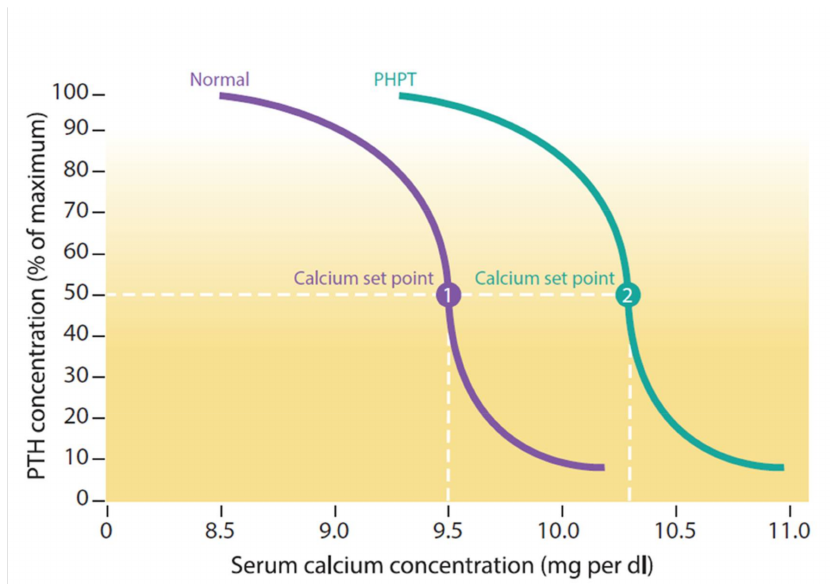
Figure 4. The purple line shows the normal relationship between calcium and parathyroid hormone concentrations and the green primary hyperparathyroidism (PHPT) curve is shifted to the right (higher levels of PTH at each calcium). The calcium set point (dotted line) corresponds to the concentration of calcium at which PTH secretion is at 50%. In primary hyperparathyroidism (PHPT), PTH is less sensitive to calcium, leading to higher levels of calcium